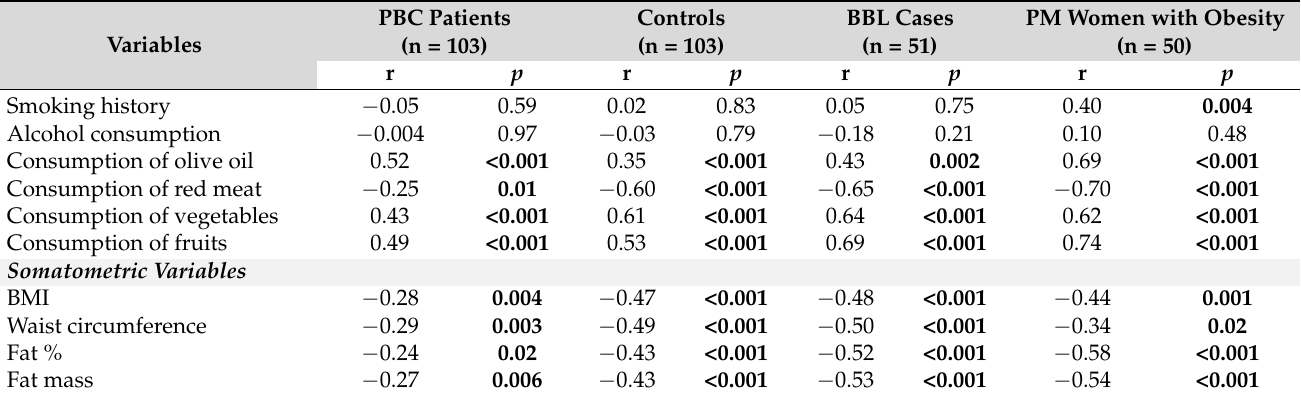
Table 2. Spearman correlations of study variables with circulating omentin-1 in all participants.